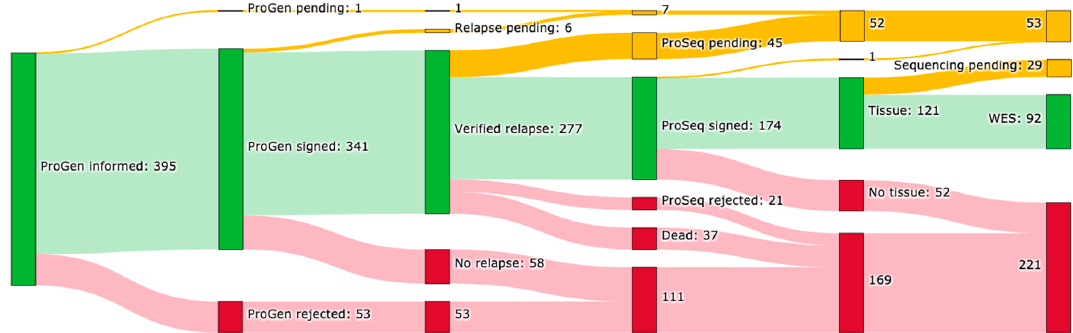
Figure 1. Inclusion overview. Number of patient cases included in the ProGen and ProSeq studies by 31 January 2019. Patient’s relapse status, presence of correct tumor tissue for analysis, and sample status is given. Color codes: green: yes, yellow: pending, and red: no.